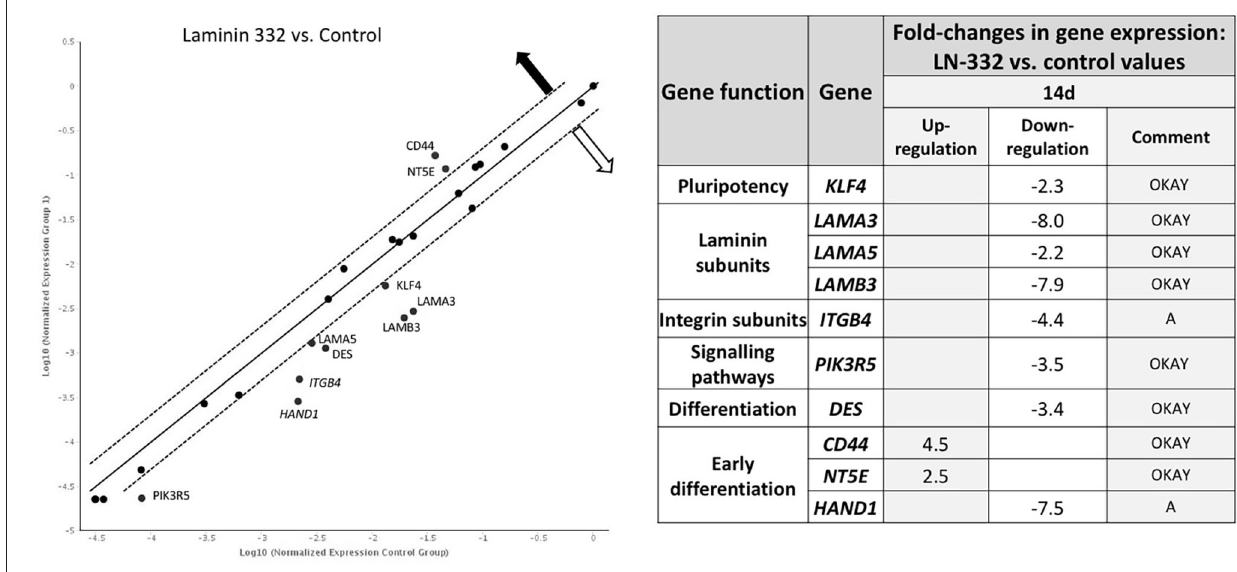
FIGURE 5 | Gene expression profile after 14 days of culture on LN332-coated plates comparing to control plates. Table shows statistcally significant fold-changes in gene expression. Dotted line: expression changed 2-fold ( p < 0.05). OKAY: The gene’s expression is relatively high in both the test and control group. The threshold cycle (CT) is < 30. A, This gene’s average threshold cycle is relatively high ( > 30) in one sample and is reasonably low in the other sample ( < 30). These data mean that the gene’s expression is relatively low in one sample and reasonably detected in the other sample; —overexpression